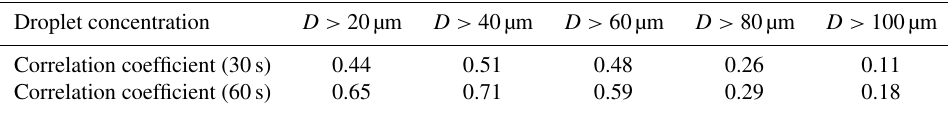
Table 2. Correlation coefficient in different size ranges between droplet concentration and concentration of small faceted ice crystals with L max < 100µm for the cloud segment in Fig. 13 with 30 and 60s